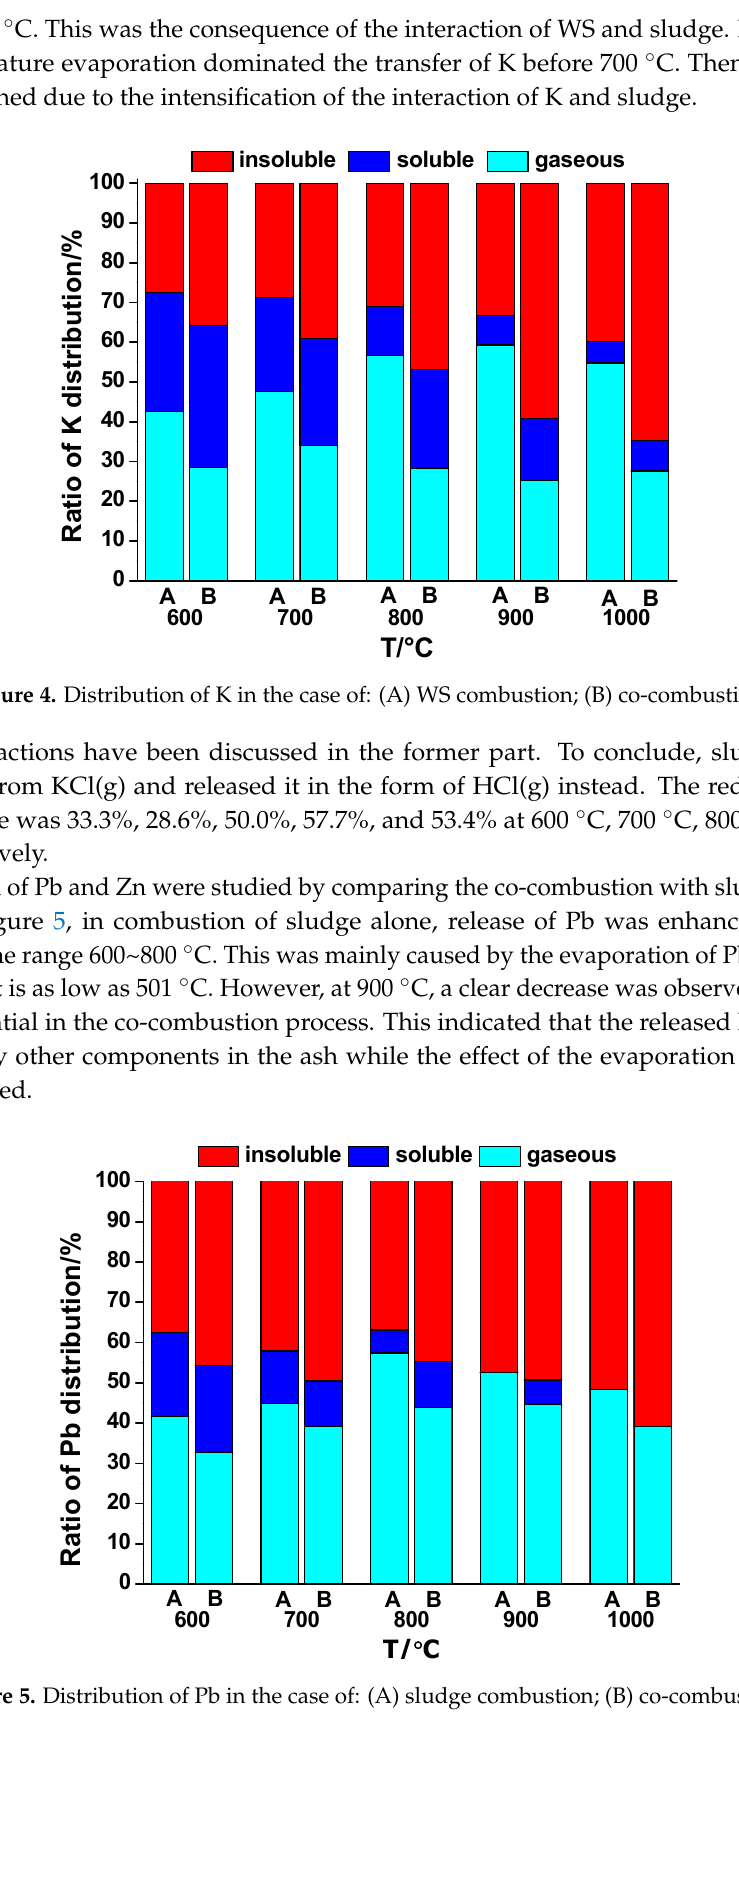
B Figure 6. Distribution of Zn in the case of: ( A ) sludge combustion; ( B ) co-combustion. For Zn distribution in the sludge combustion, from Figure 6 it was obvious that release of Zn and transfer from the soluble part to the insoluble part were also enhanced by the rising temperature. At 600 °C, the release ratio of Zn was only 25.7% and its maximum value reached 37.1% at 900 °C. The release rate was obviously lower than Pb. The soluble part of Zn in the solid phase reduced from 14.7% to 0% meanwhile. Similar to Pb, co-combustion restrained the release of Zn compared with sludge combustion and the value was in the range of 30.5% to 44.3% and the reducing effect of co- combustion was the most notable at 800 °C. With the temperature rising, the dissimilarity tended to be insubstantial. It should be pointed out that co-combustion reduced the soluble part of Zn in the ash and the ratio was below the detection limit since 800 °C. To conclude, the effect of co-combustion on Zn was